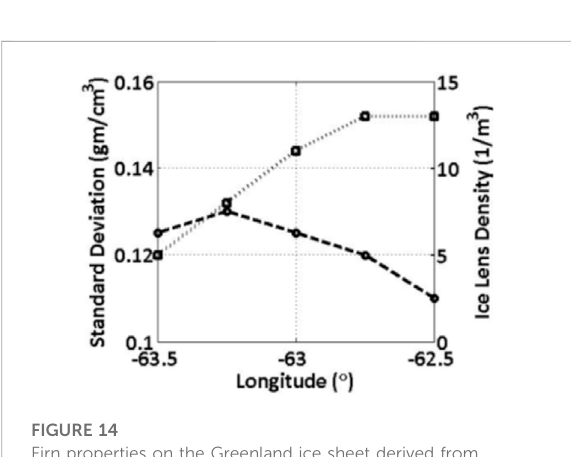
FIGURE 14 Firn properties on the Greenland ice sheet derived from ultrawidebanddata (Figure 8).Icelensdensity decreases eastward as elevation and hence surface temperature decreases. The variability of fi rn layer increases eastward as the short term and annual density variations become dominant(From Jezek et al.,